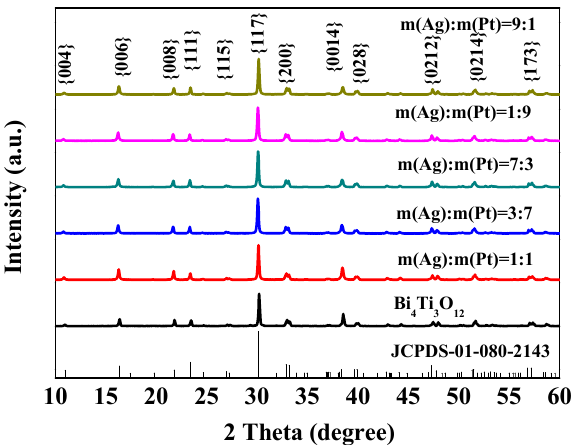
Figure 1. X-ray diffraction (XRD) patterns of Bi 4 Ti 3 O 12 and (AgPt) 0.001 / Bi 4 Ti 3 O 12 composite photocatalysts prepared by photoreduction method.